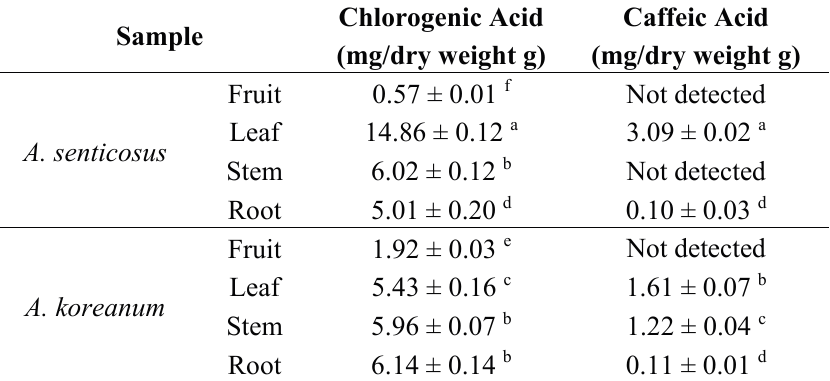
Table 3. Chlorogenic acid and caffeic acid contents in the different parts of A. senticosus and A.